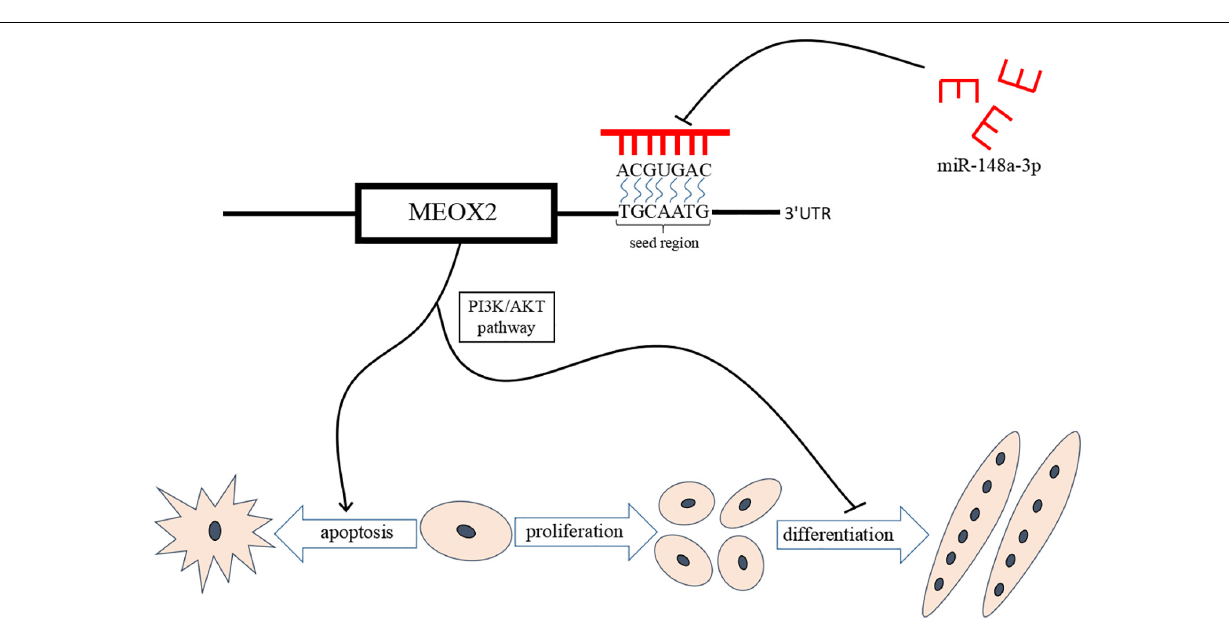
Frontiers in Genetics |